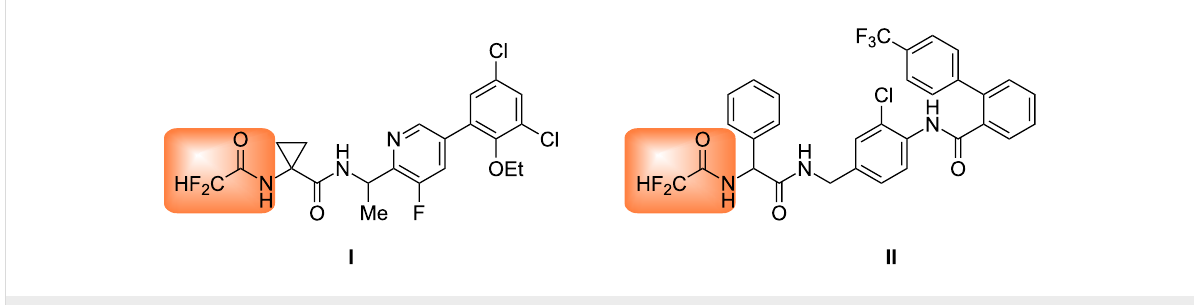
Figure 1: Two examples of bioactive pseudopeptides bearing a CF 2 H group.